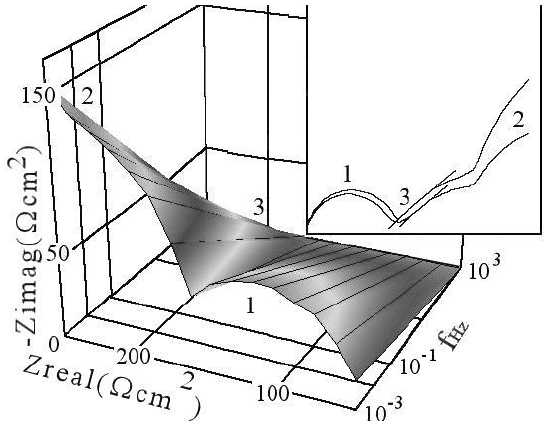
Figure 5. Nyquist diagram for palladium charged in hydrogen. Applied potential between peak A and